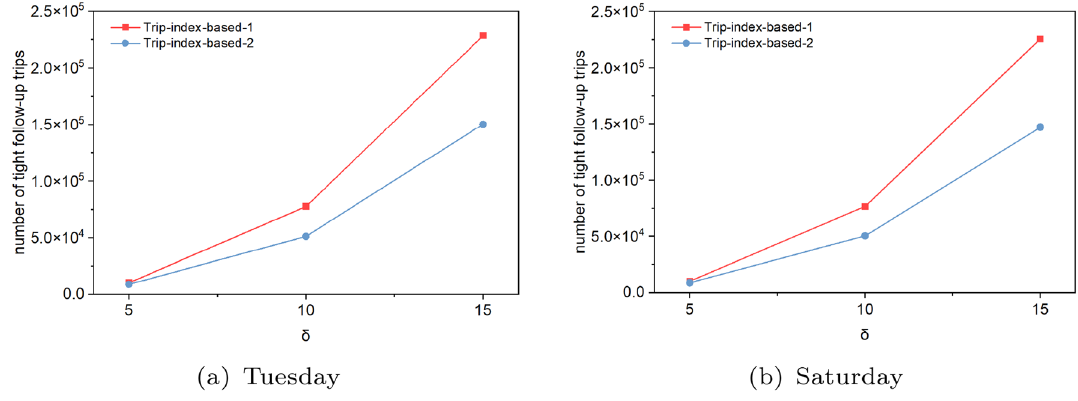
Fig. 18 Number of tight follow-up trips found